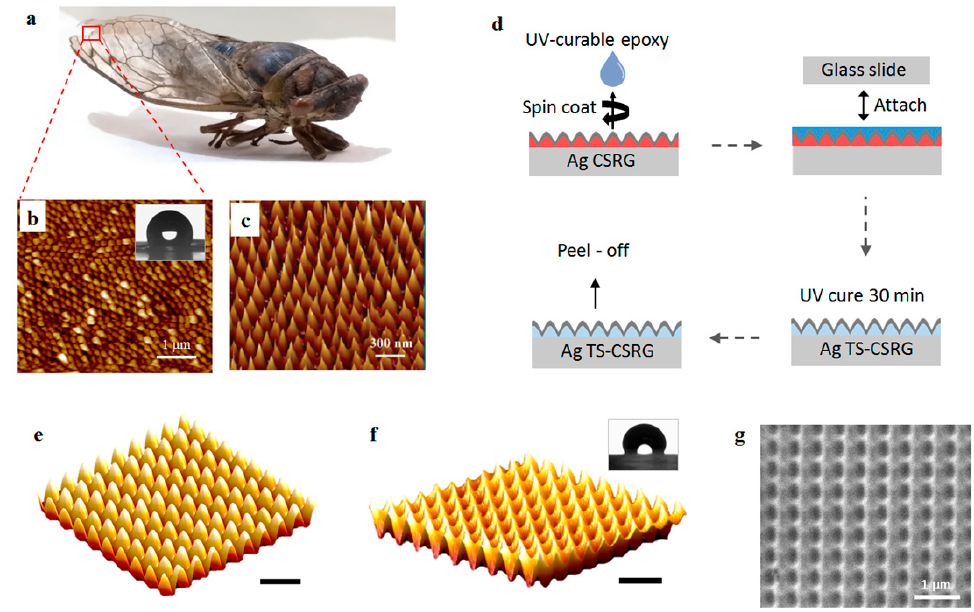
Figure 1. ( a ) Picture of a cicada Neotibicen canicularis . ( b ) atomic force microscope (AFM) image of the external surface from a piece of the wing of the cicada; inset: wetting state of a water droplet on a cicada Neotibicen canicularis. ( c ) AFM image of the external surface of the wing of a cicada Cryptotympana atrata fabricius . Reprinted with permission [48]. Copyright 2017, The Royal Society of Chemistry. ( d ) Schematic representation of the fabrication procedure for creating template-stripped Ag template-stripped crossed surface relief grating (TS-CSRG). AFM scan of a 5 µ m × 5 µ m area of a 500-nm-pitch ( e ) Ag CSRG, and ( f ) Ag TS-CSRG; inset: wetting state of a water droplet on an Ag TS-CSRG; scale bars correspond to 1 µ m. ( g ) SEM image of a 500 nm-pitch Ag